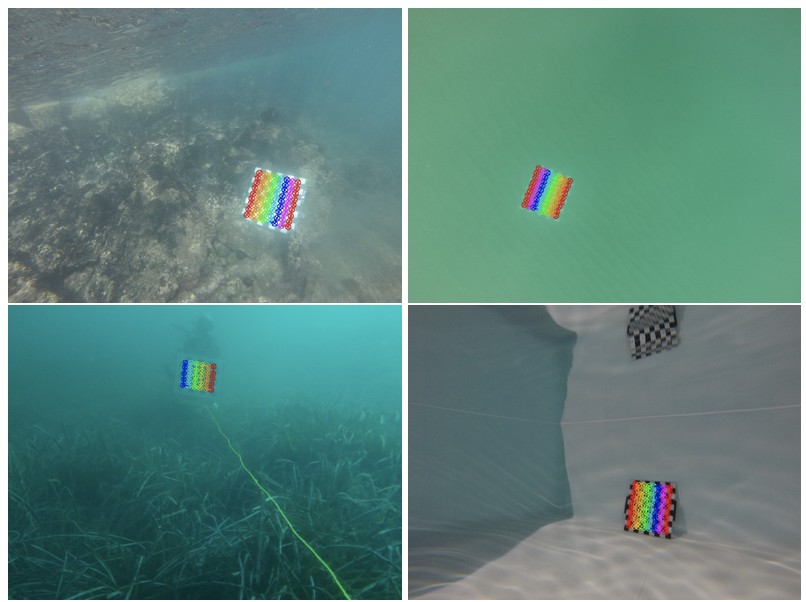
Figure 7. Final part of the chessboard detection: four examples of identified patterns whose detected intersections have been correctly ordered.